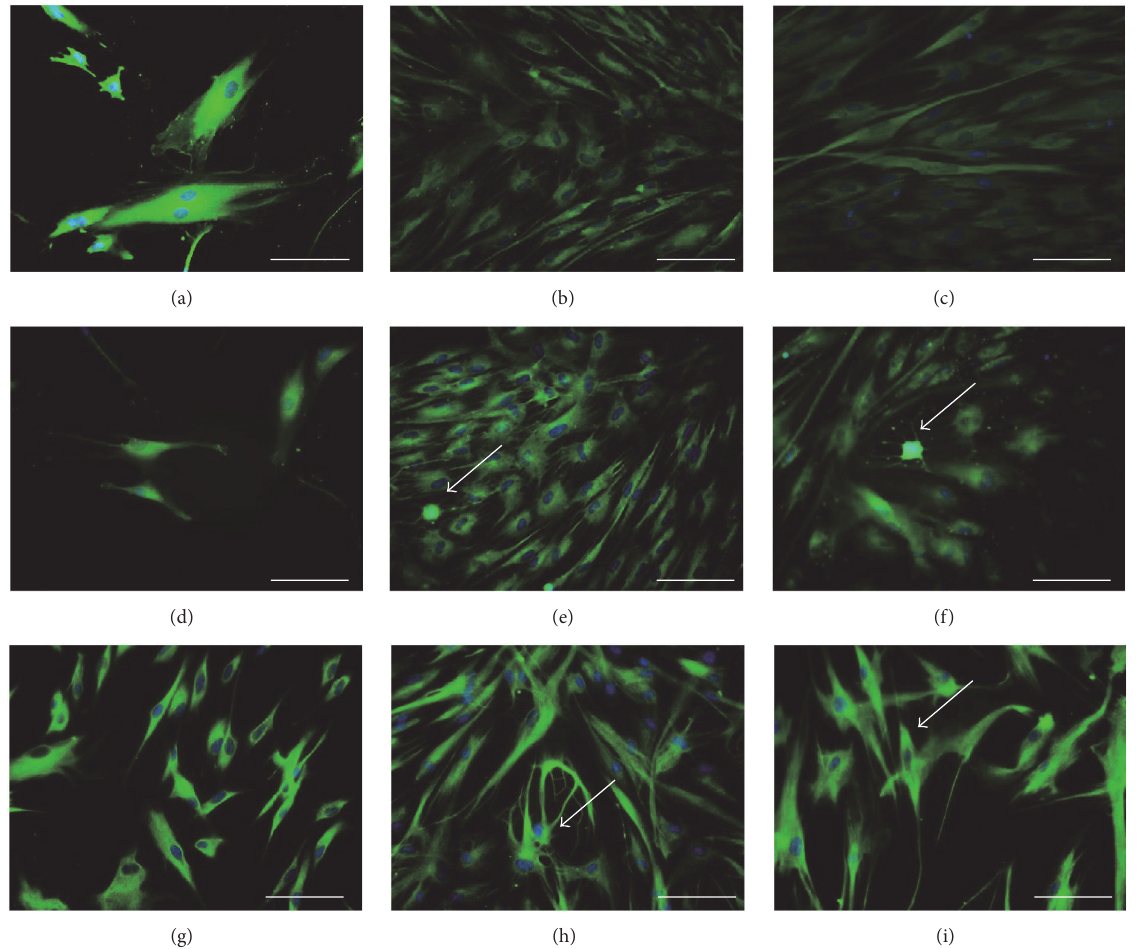
Figure 2: Immunofluorescence staining of neural markers in hDFCs during one-step neuronal induction. (a–c) Nestin staining. (d–f) 𝛽 -III- Tubulin staining. (g–i) S100 𝛽 staining. (a, d, g) Undifferentiated hDFCs (day 0). (b, e, h) hDFCs on day 3 after neuronal induction. (c, f, i) hDFCs on day 7 after neuronal induction. Scale bars = 50 𝜇 m. Arrows indicate neural-like cells with branched dendrites and refractile cell